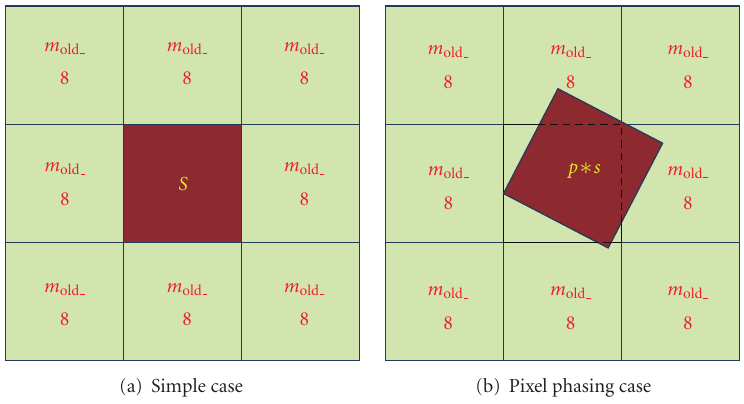
Figure 4: Pixel phasing